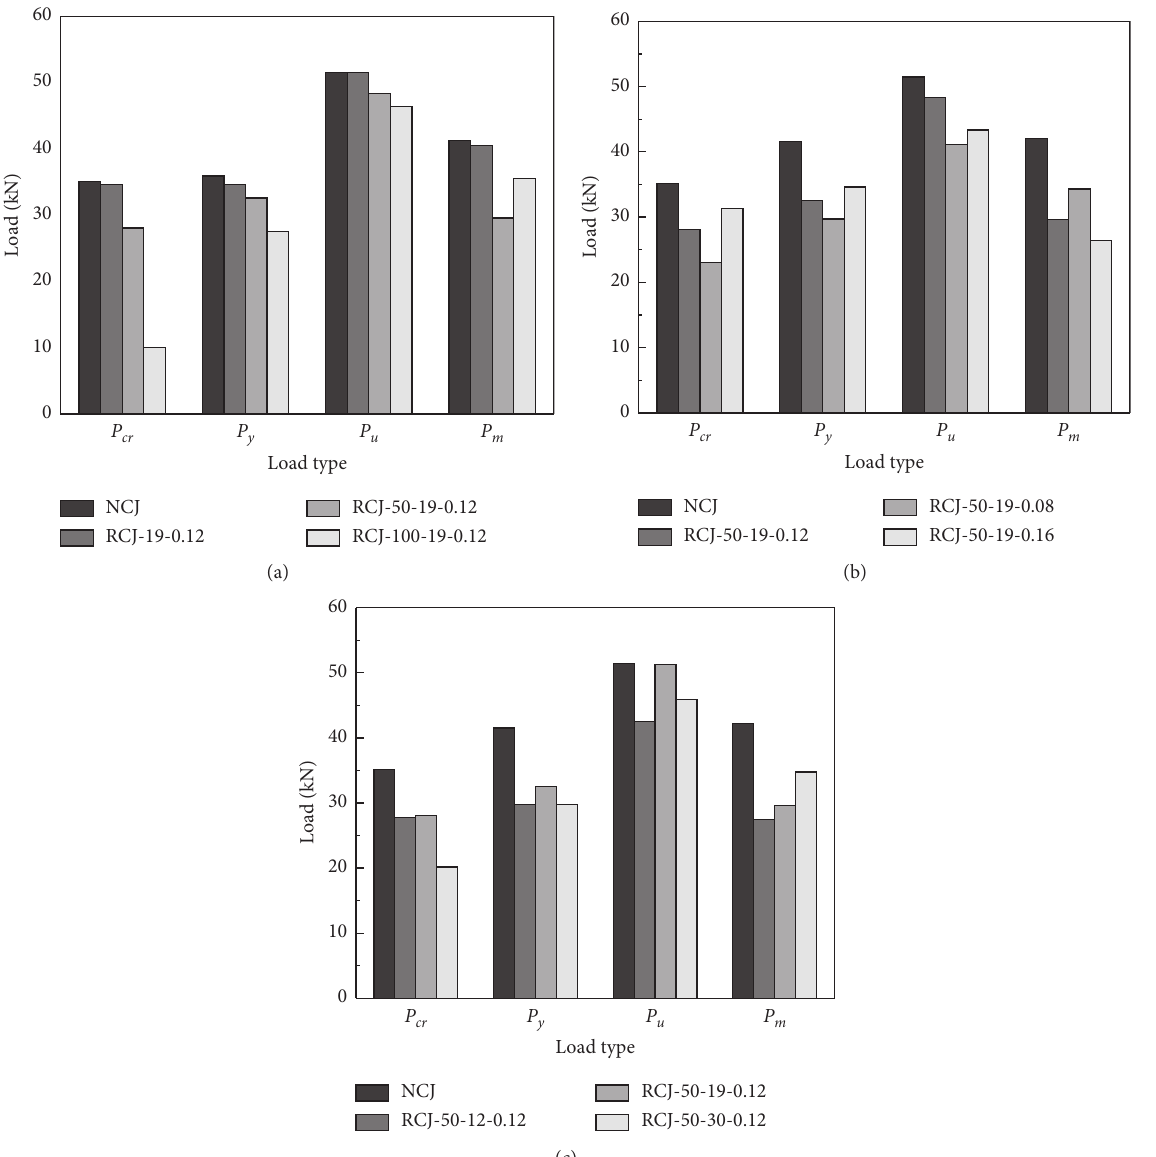
Figure 11: Comparison of influencing factors of characteristic load. (a) Replacement rate of RCA. (b) Volume of waste fibers. (c) Length of waste